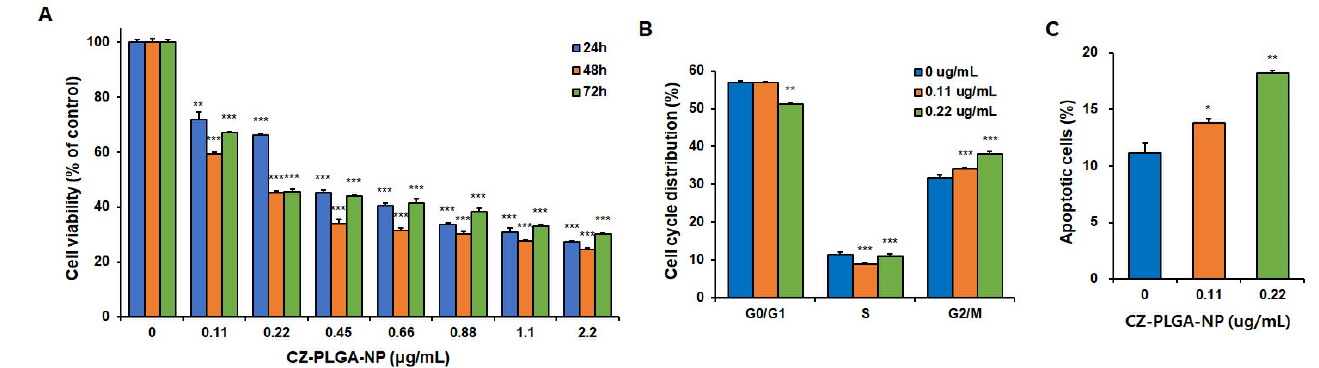
Figure 5. In vitro effects of CZ-PLGA-NPs on the cell viability, cell-cycle progression, and apoptosis of Renca-SRLu5-Luc cells. ( A ) In vitro cytotoxicity assay of CZ-PLGA-NPs against Renca-SRLu5-Luc cells incubated with different concentrations of CZ-PLGA-NPs for 24, 48, and 72 h; ( B ) Effect of CZ-PLGA-NPs on the cell cycle distribution of Renca-SRLu5-Luc cells as determined by flow cytometry based on propidium iodide (PI) staining; ( C ) Effect of CZ-PLGA-NPs on apoptosis of Renca-SRLu5-Luc cells determined using flow cytometry based on the Annexin V–FITC/PI double staining. Each point represents the mean ± SD of three independent experiments. * p < 0.05; ** p < 0.01; *** p < 0.001.